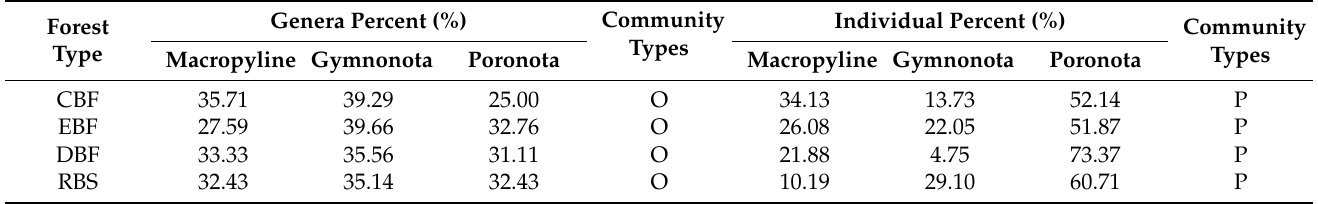
Table 8. Community structure of soil mites (Acari: Oribatid) at four typical vegetation in the study